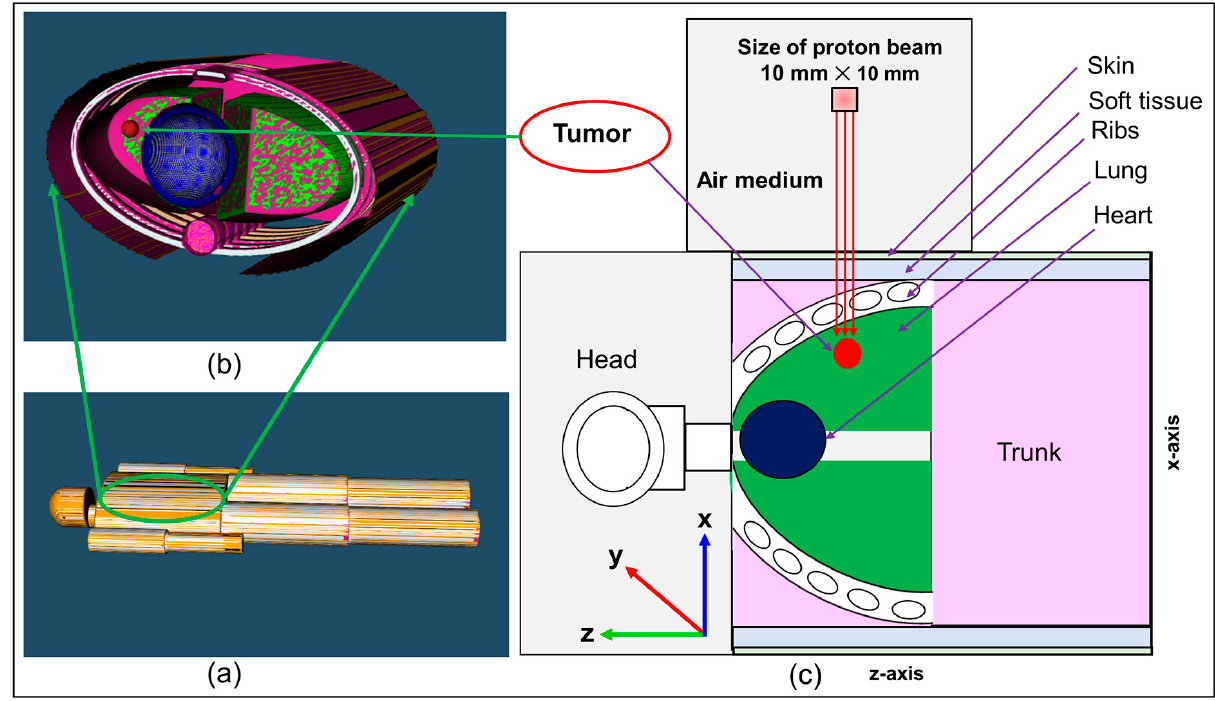
Figure 2. The modelled MRID anthropomorphic phantom with tumor location marked. The irradiation of the spherical tumor placed at left lung is also shown with a 10 × 10 mm 2 field size. The tumor located in the left lung of the modelled MIRD anthropomorphic phantom was irradiated with 80 MeV monoenergetic incident proton beam (see Figure 2). The irradiation field size set to be a 10 × 10 mm 2 squared shaped source. The beam was perpendicular to the tumor volume along the negative y -axis. A total of 10 9 incident protons were launched from the source, to minimize the statistical uncertainties associated with MC